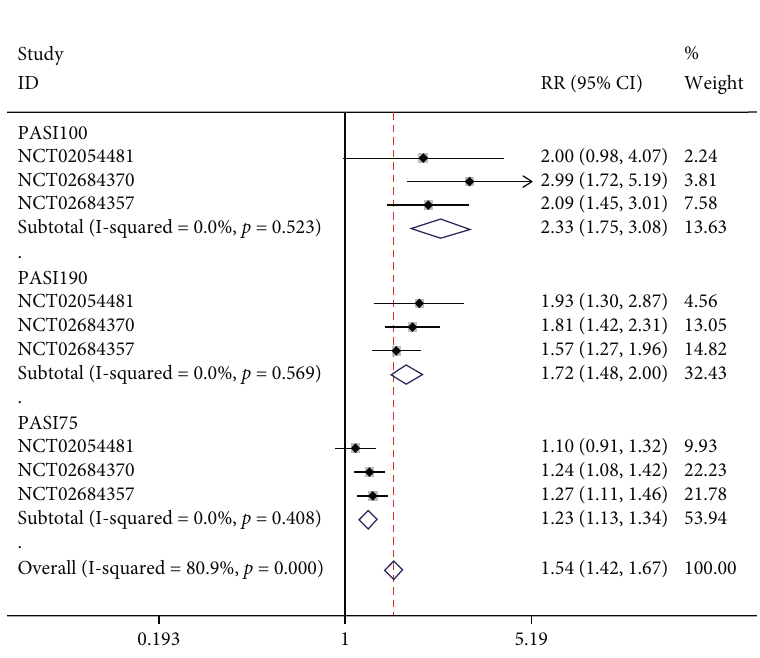
Figure 4: Forest plot of short-term PASI